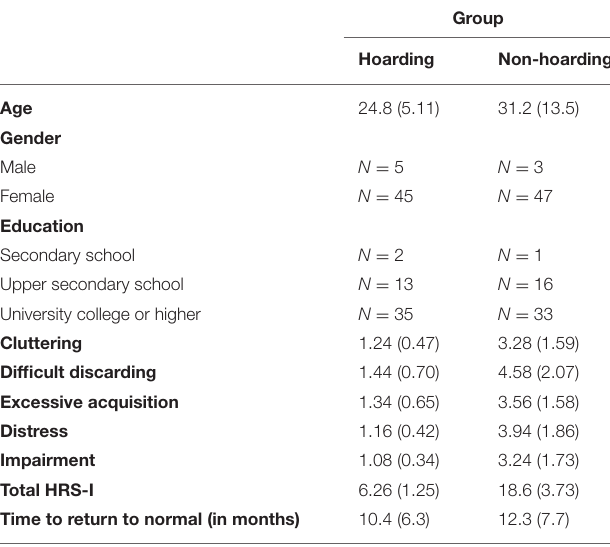
TABLE 1 | Descriptive statistics for age, Hoarding Rating Scale-Interview (HRS-I) scores, and time estimation scores.